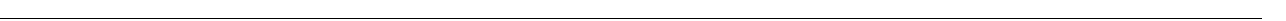
Fig. 2 Interfocal and intrafocal genetic heterogeneity of MSLC. a A schematic overview of tumor heterogeneity analysis at interpatient, interfocal and intrafocal levels. b Mutation spectra of four MSLC patients were summarized by pie charts and shared mutations between different subjects were showed in Venn diagram. c Overexpression of indicated wild-type or mutant genes in BEAS-2B or LXF-289 cells. Gene expression and ERK phosphorylation were measured by immunoblotting. d Indicated wild-type or mutant genes were lentivirally introduced into BEAS-2B or LXF-289 cells. Cells were cultured for two weeks and stained with crystal violet. Scale bar, 5 mm. e Tumor growth of BEAS-2B xenografts that ectopically expressed indicated mutant genes. Each line represented mean tumor volume of the respective group, and error bars indicated standard deviation (10 mice per group). Scale bar, 10 mm. f A heat map presented the CCF of putative driver mutations in each sequenced region of the MSLC tumors. g Mutation spectra of early mutations (trunk) and late mutations (branch), and mutational signatures of different tumor regions in M-seq samples of RJLC1-T1 and